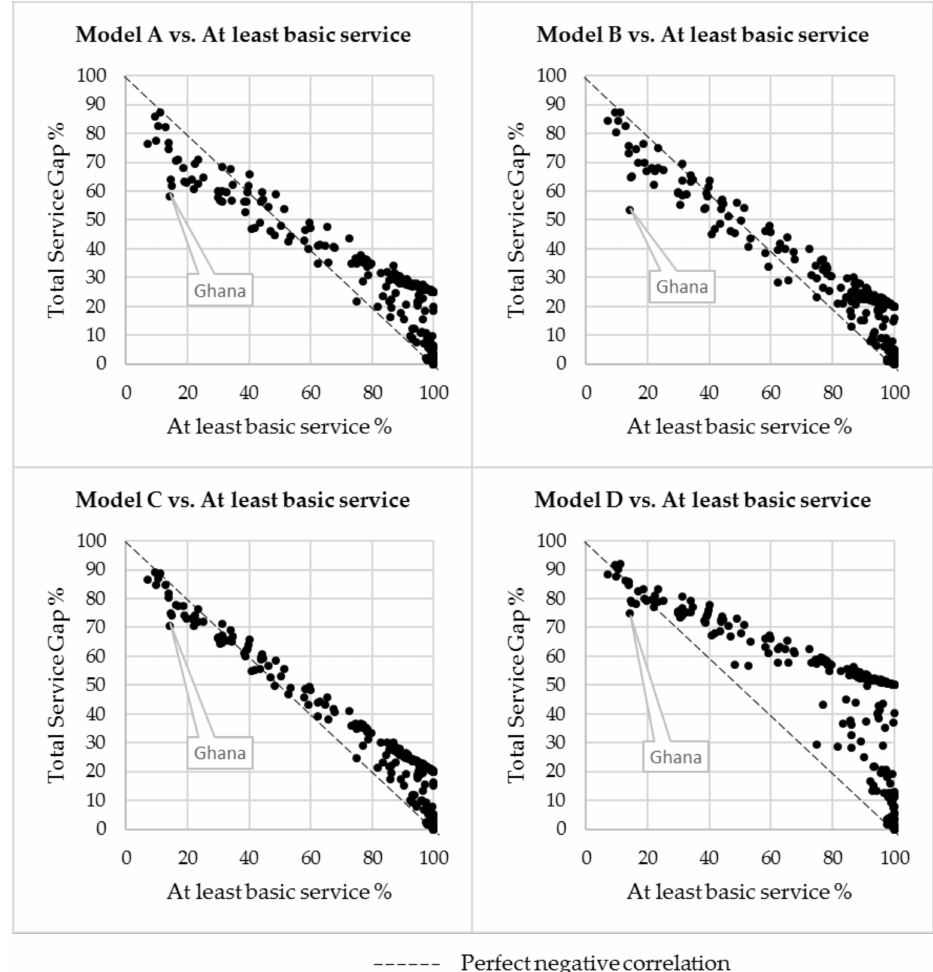
Figure 1. The correlation of the ‘total service gap’ with ‘at least basic services’ for Models